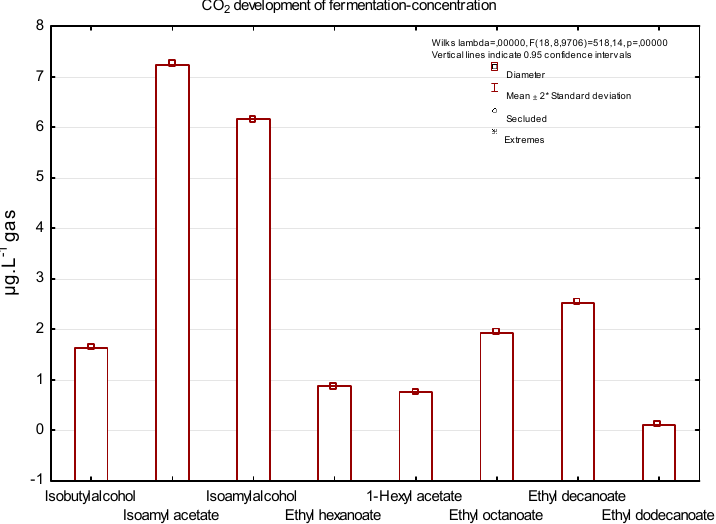
Figure 3. The concentrations of significant aromatic substances in the final mixture of fermentation